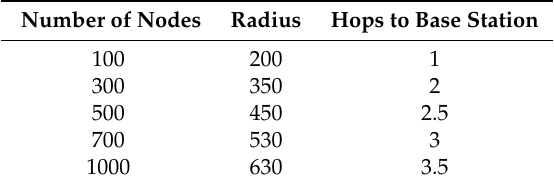
Table 6. Larger network parameters scaled from base N = 100 node network.